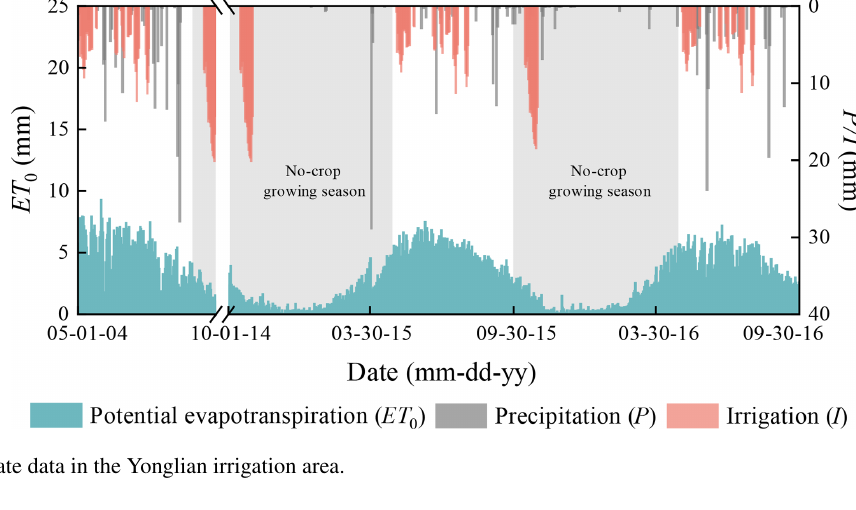
Figure 9. Daily climate data in the Yonglian irrigation area.